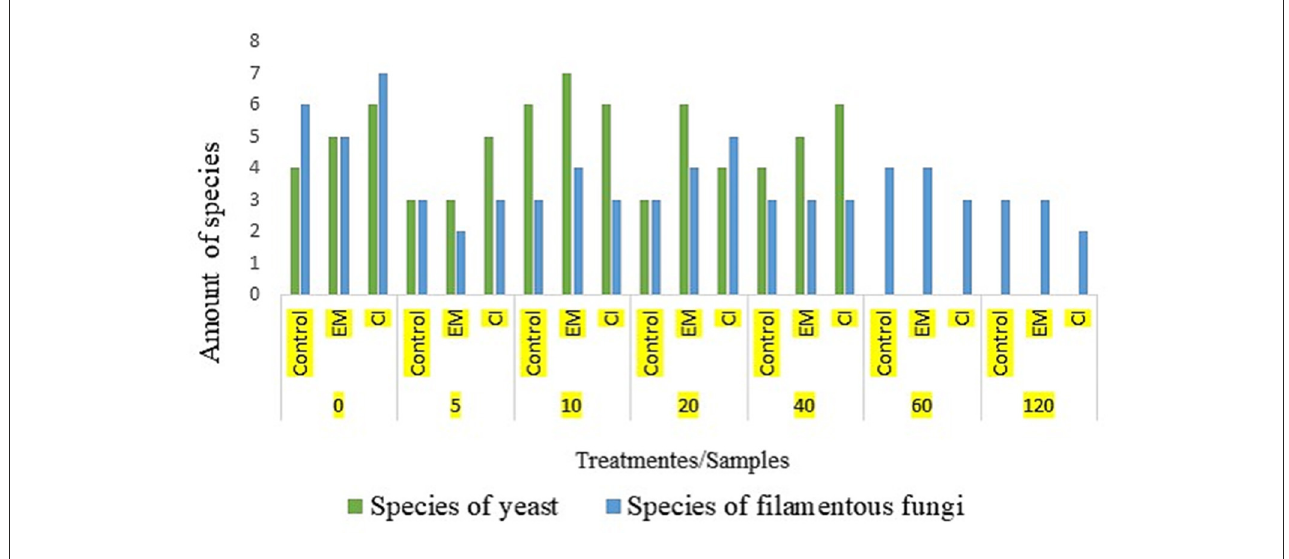
FIGURE3 Species richness in each phase and each